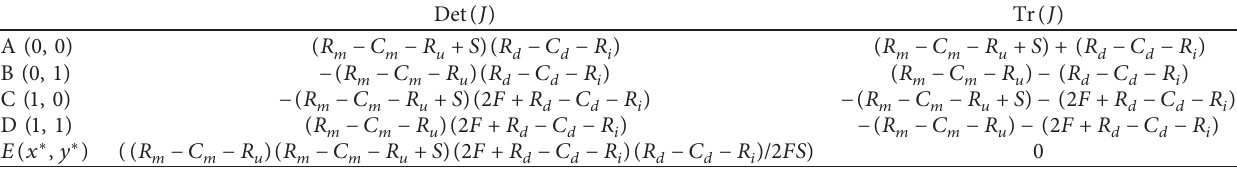
Table 3: Determinant and trace of partial equilibrium points.